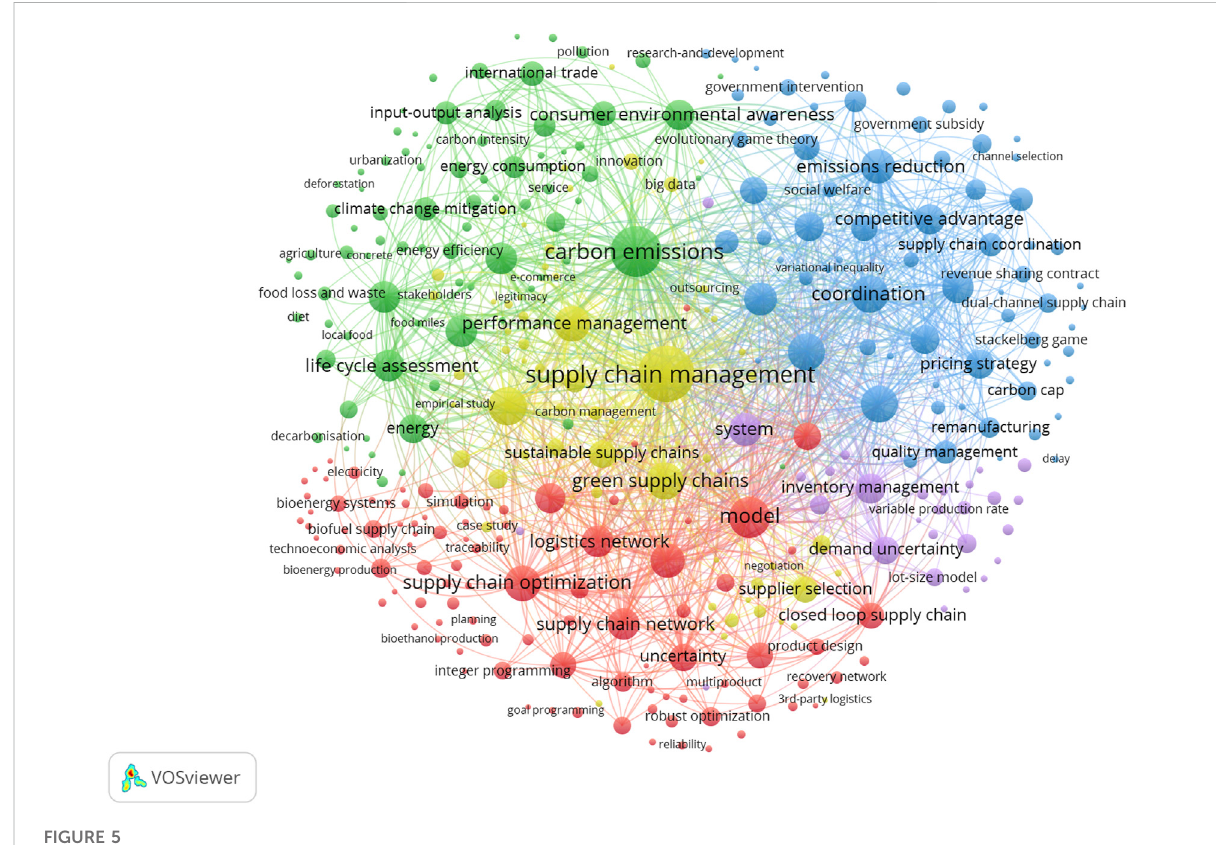
FIGURE 5 The clusters of keywords in LCSC.